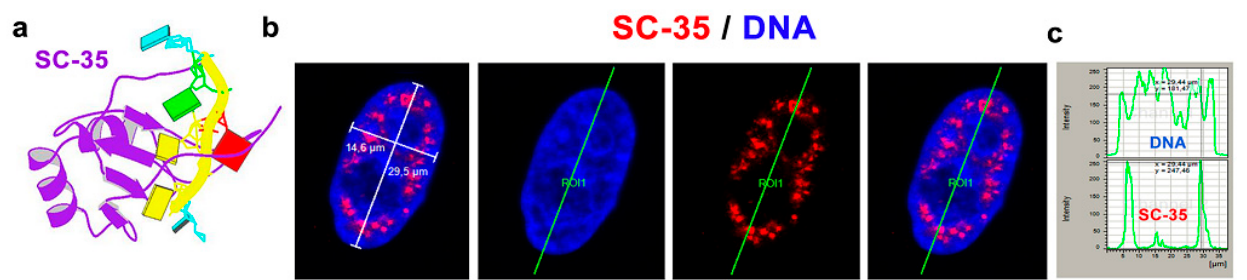
Figure 1. Structure and nuclear distribution of the SC-35 protein. ( a ) The structure of SC-35 protein in a complex with 5 ′ -UCCAGU-3 ′ motif was adapted from the PDB database (deposition authors were Daubner et al. [47]). ( b ) The SC-35 protein (red fluorescence) was localized in 52.2 ± 3.5% of the nuclear radius (measured in 50 cells in each experiment, repeated thrice). ( c ) Analysis of fluorescence intensity showed that SC-35 occupies sites with a low chromatin density, as visualized by the 4 ′ ,6-diamidino-2-phenylindole (DAPI) staining (blue fluorescence).